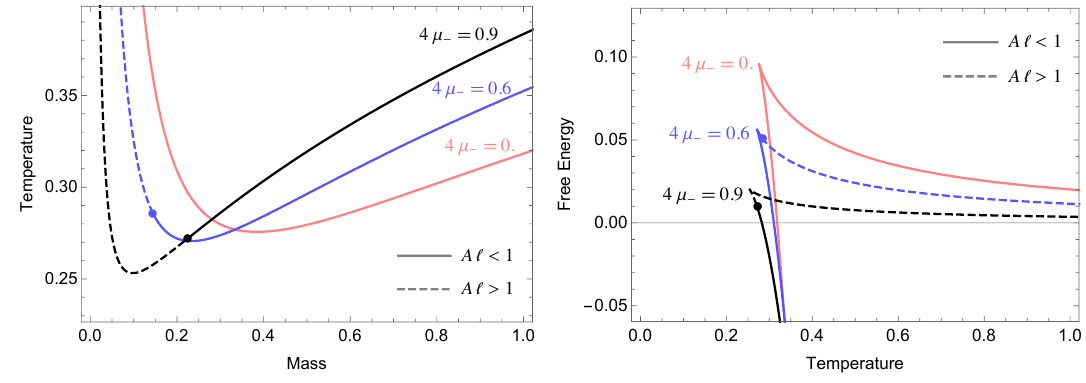
Figure 3 . Left: a plot of temperature as a function of mass (in units of ‘ ) for the uncharged black hole. The slowly-accelerating r(cid:19)egime is shown as a solid line, and the inferred local horizon temper- ature for A‘ > 1 is shown dashed. Note how for larger string tension (hence greater acceleration) the region of positive speci(cid:12)c heat increases. Right: a similar plot, but now showing the Gibbs free energy as a function of